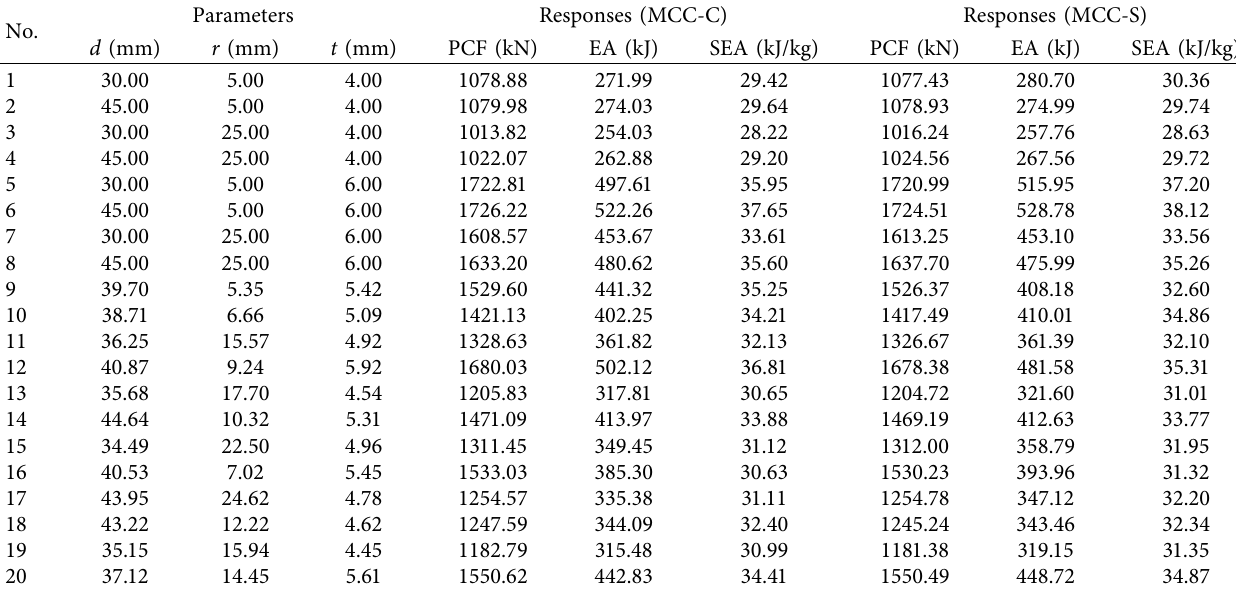
Table 6: Design matrixes of MCC-C and